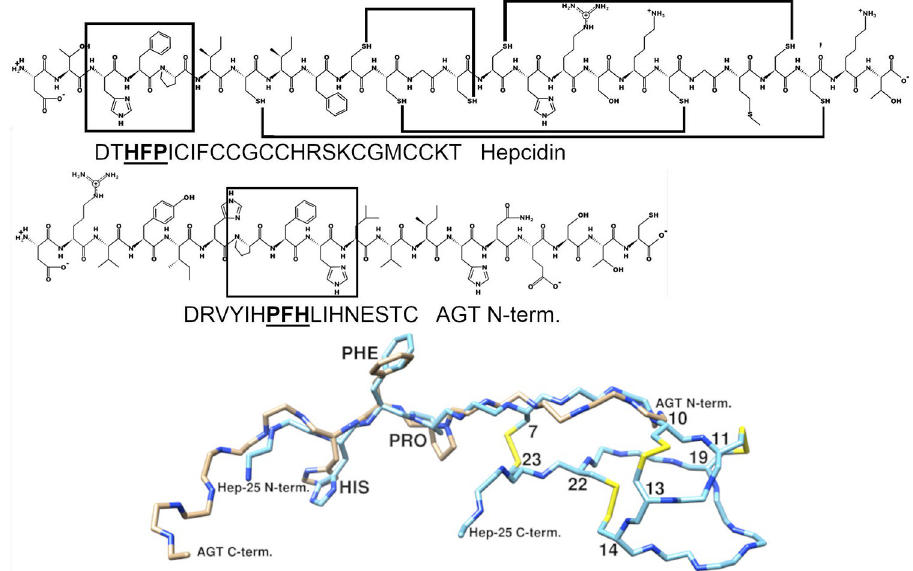
Fig 1. Similarity of amino acid sequences and structural formulas of hepcidin hormone and N-terminal part of the human angiotensinogen. A similar binding motif and its amino acids histidine, phenylalanine and proline are framed and written in bold. The 3-dimensional structure of Hep-25 (chain from PDB notation 4qae), and the N- terminal structure of the human angiotensinogen (chain from PDB notation 6i3f) are coloured with cyan and brown respectively. In addition, the four disulfide bonds of hepcidin are in yellow and their cysteine amino acids are numbered.